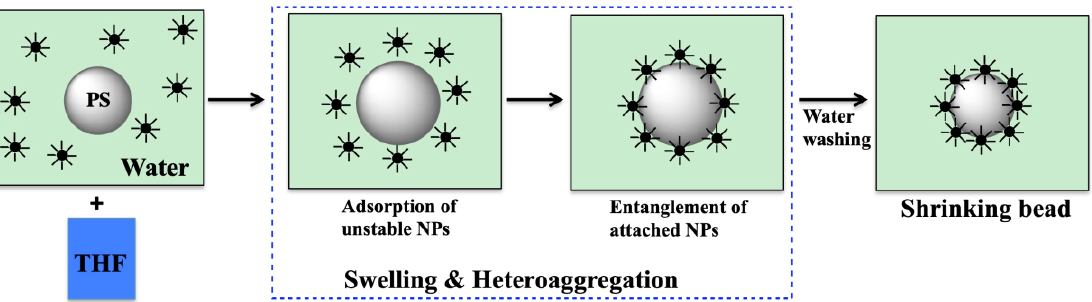
Figure 8. Schematic representation of a combined swelling-heteroaggregation methodology. Redrawn by adaptation from Reference [57]. Copyright (2009) American Chemical Society.